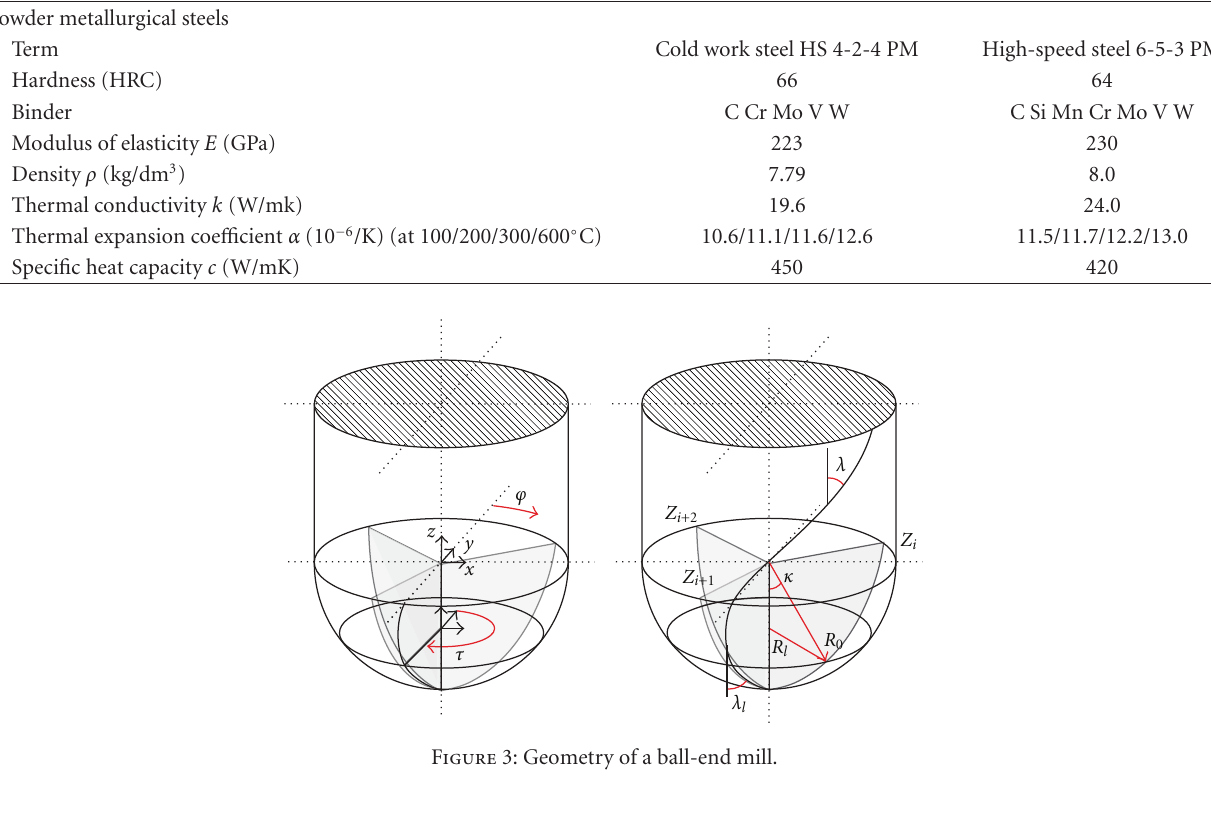
Table 2: Work piece materials.